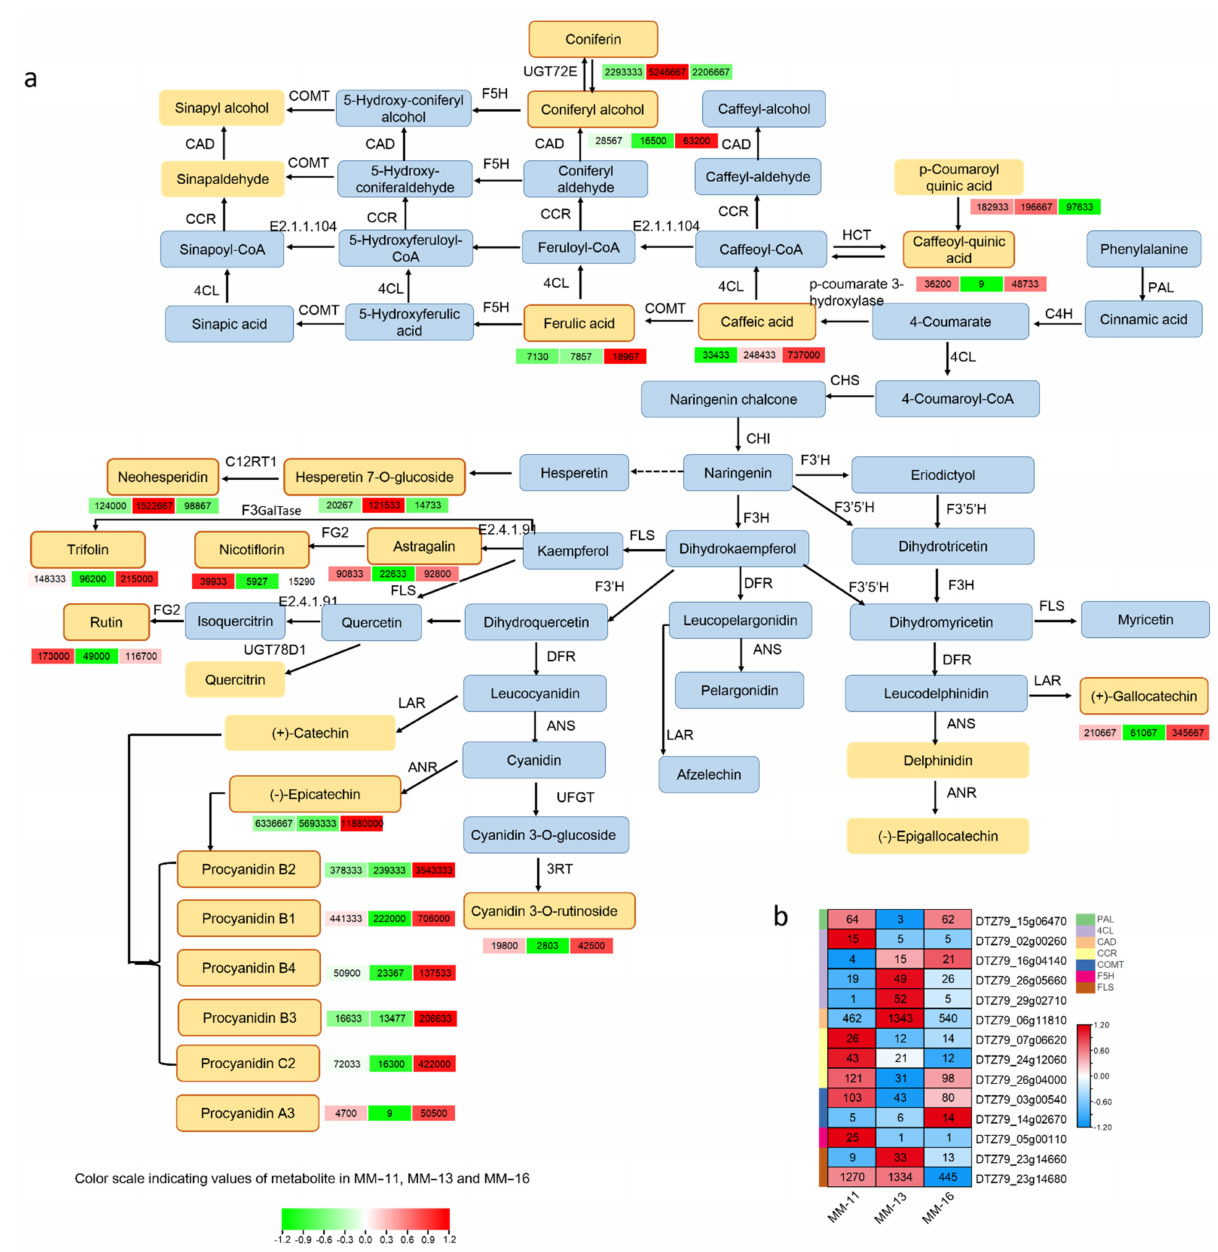
Figure 5. The phenolic acid, flavonoid and anthocyanin synthesis pathway of A. eriantha fruit. De- tected metabolites are in yellow, and red squares indicate DAMs. The heatmap of DAMs ( a ) content and DEGs ( b ) in MM-11, MM-13 and MM-16 is shown. PAL, phenylalanine ammonia-lyase; C4H, cin- namic acid 4-hydroxylase; 4CL, 4-coumarate CoA ligase; CHS, Chalcone synthase; CHI, Chalcone iso- merase; F3H, Flavonoid 3-hydroxylase; F3 (cid:48) H, Flavonoid 3 (cid:48) -monooxygenase; F3 (cid:48) 5 (cid:48) H, Flavonoid 3 (cid:48) ,5 (cid:48) - hydroxylase; DFR, Dihydroflavonol 4-reductase; ANS, Anthocyanidin synthase; ANR, anthocyani- din reductase; LAR, leucoanthocyanidin reductase; UGT78D1, flavonol-3-O-rhamnosyltransferase; FG2, flavonol-3-O-glucoside L-rhamnosyltransferase; E2.4.1.91, flavonol 3-O-glucosyltransferase; F3GalTase, kaempferol 3-O-galactosyltransferase; C12RT1, flavanone 7-O-glucoside 2 (cid:48)(cid:48) -O-beta-L- rhamnosyltransferase; COMT, caffeate 3-O-methyltransferase; CCR, cinnamoyl-CoA reductase; CAD, cinnamyl-alcohol dehydrogenase; UGT72E, coniferyl-alcohol glucosyltransferase; HCT, shiki- mate O-hydroxycinnamoyltransferase; F5H, ferulate 5-hydroxylase; E2.1.1.104, caffeoyl-CoA O-